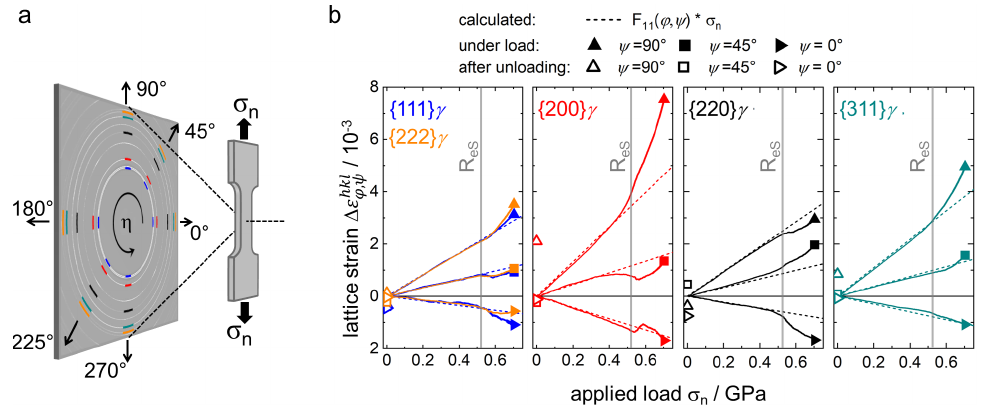
Figure 6. Debye–Scherrer rings of the austenitic phase ( γ ) of the DSS ( a ); lattice strain vs. applied load for three selected directions ψ = η = 0 ◦ , ψ = η = 45 ◦ and ψ = η = 90 ◦ experimentally determined (solid lines) and calculated (dotted lines) for lattice planes { 111 } γ , { 200 } γ , { 220 } γ , { 311 } γ and { 222 } γ ( b ).